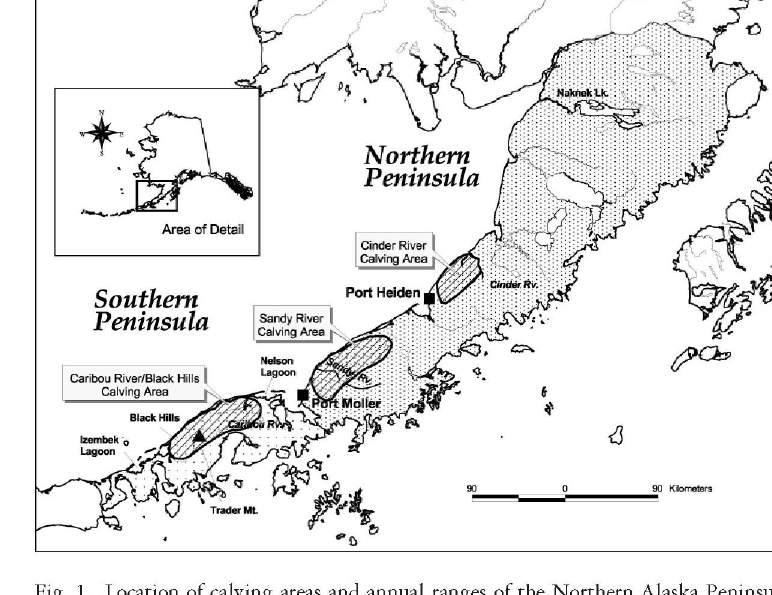
Fig. 1. Location of calving areas and annual ranges of the Northern Alaska Peninsula (NAP) and Southern Alaska Peninsula (SAP) caribou